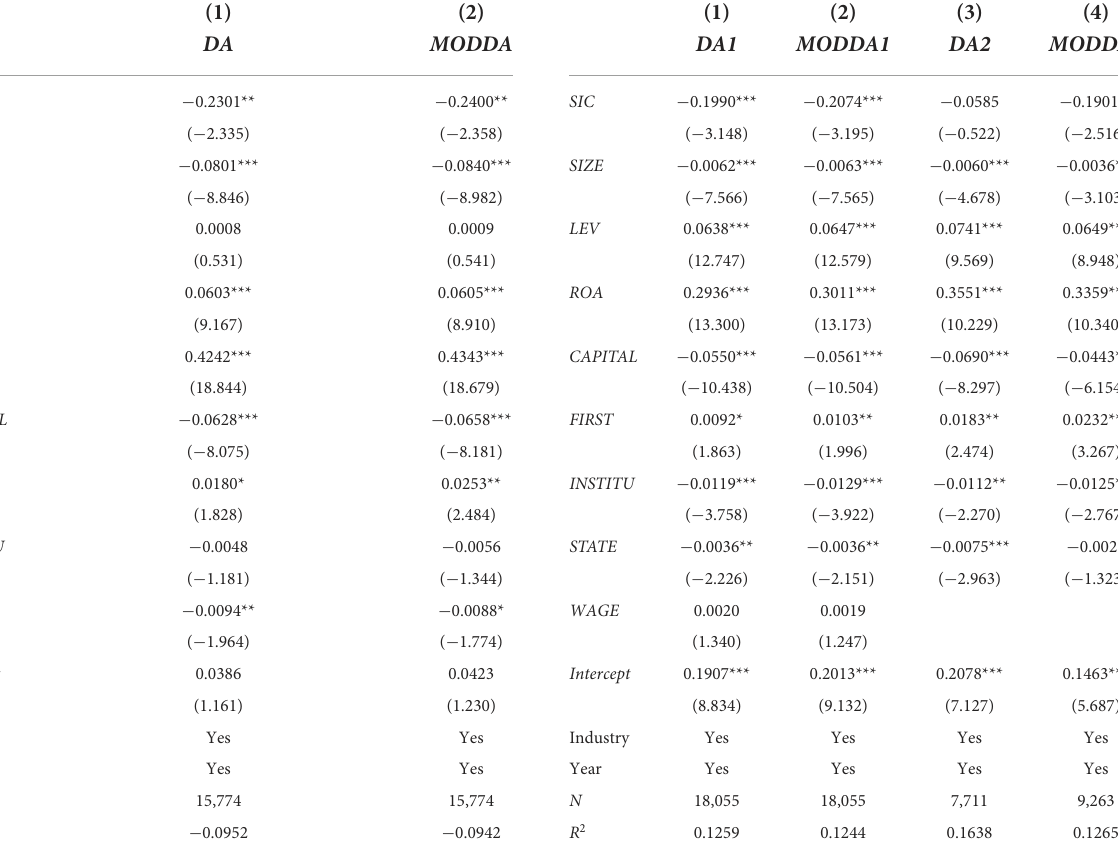
TABLE 6 Controlling fixed effect at the corporate level and intensity of regional tax bureau.